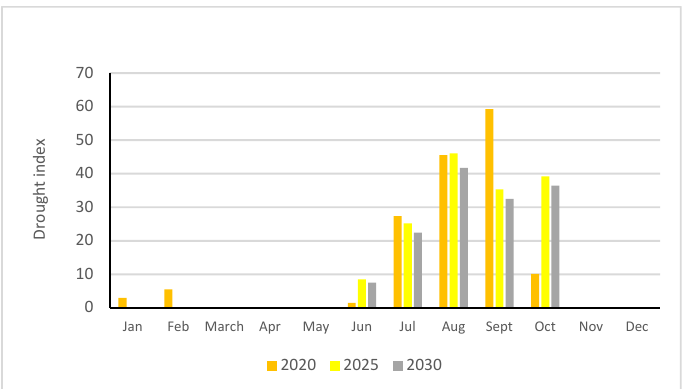
Figure 10. Change of the Drought Index in the years 2020, 2025, and 2030 based on the simulation with scenario one in the Dodokan Watershed.